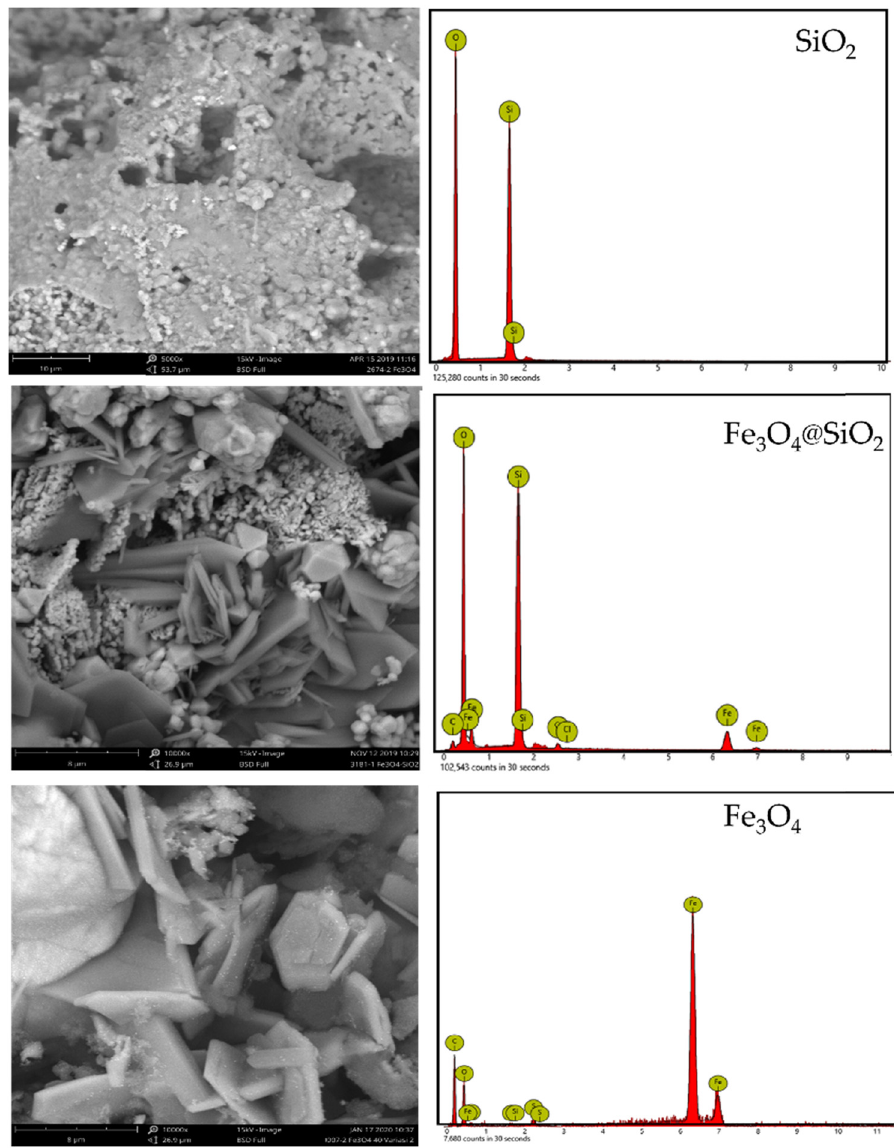
Figure 2: SEM images of Fe 3 O 4 @SiO 2 , Fe 3 O 4 , and SiO 2 .